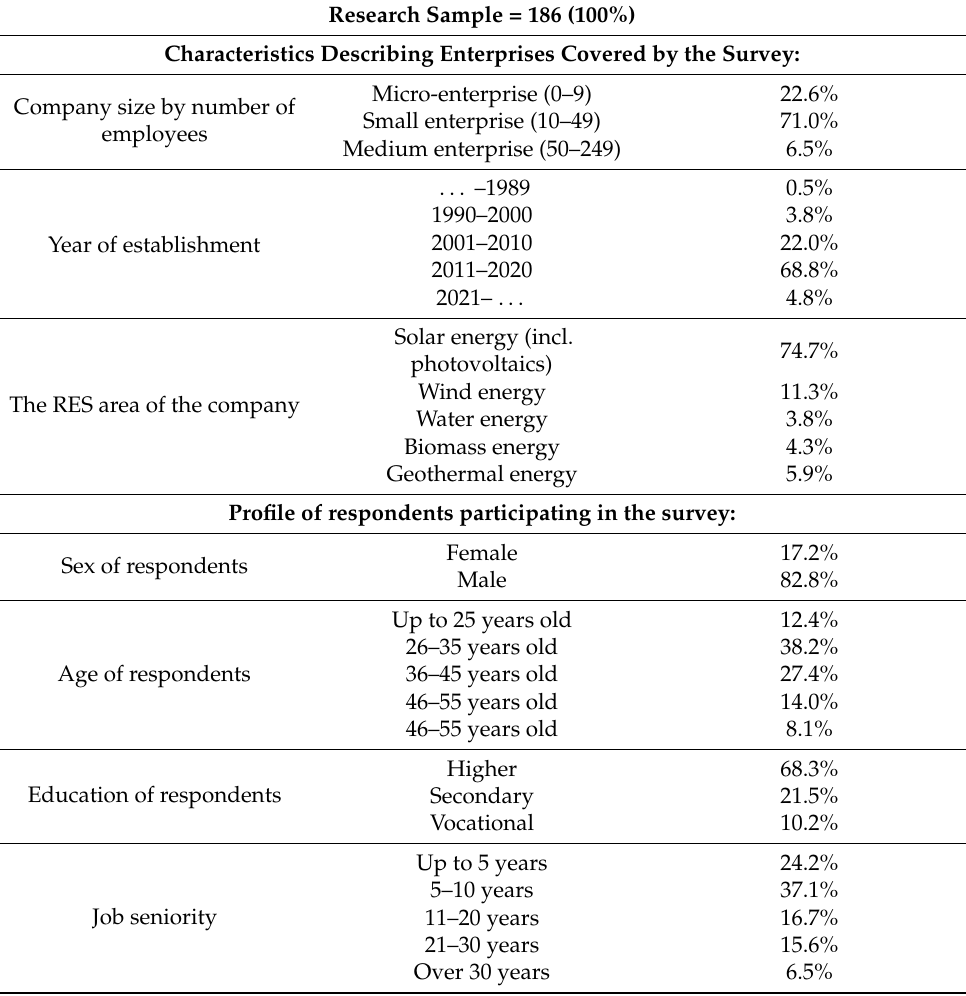
Table 1. Characteristics of the research